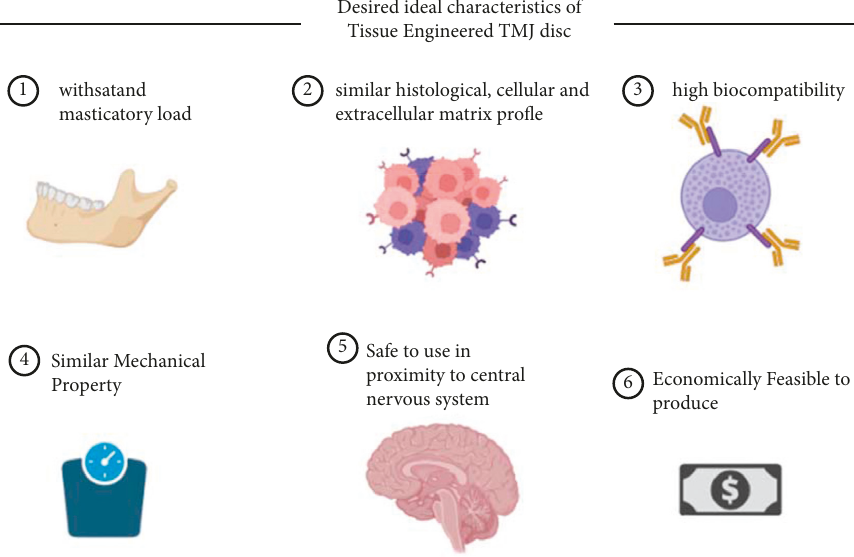
Figure 3: Ideal desired characteristics of a TE TMJ